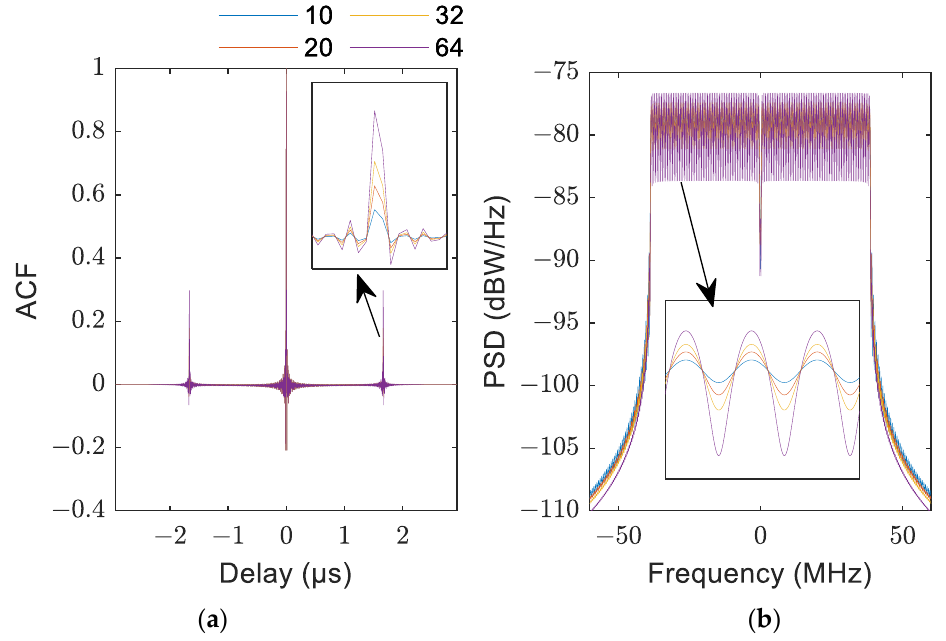
Figure 8. Effect of the guard interval length on the ACF and PSD. ( a ) The ACF of the OFDM navigation signals with different cyclic prefix lengths; ( b ) The PSD of the OFDM navigation signals with different cyclic prefix lengths.